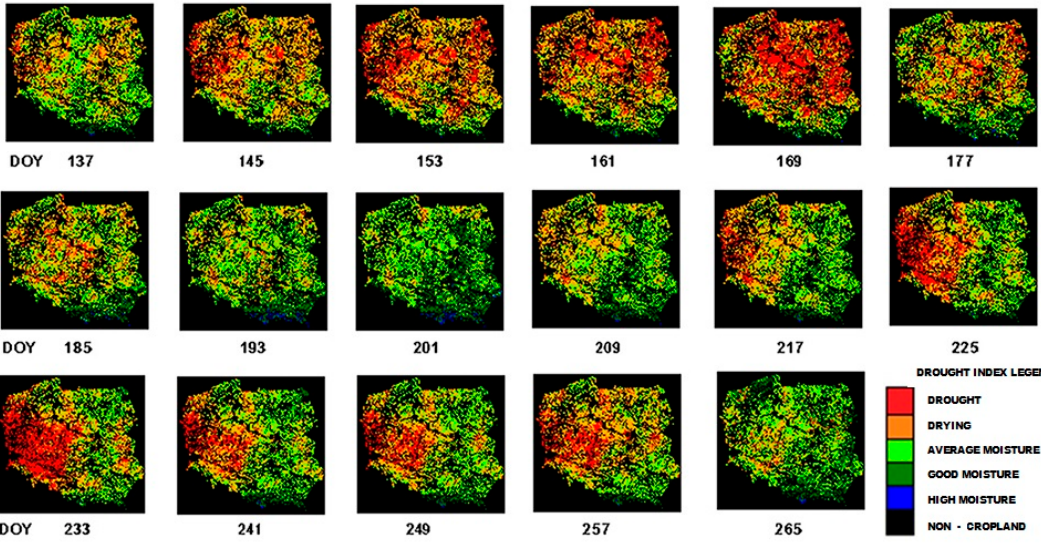
Figure 16. Distribution of the DISS MODIS drought index in the 2018 growing season.